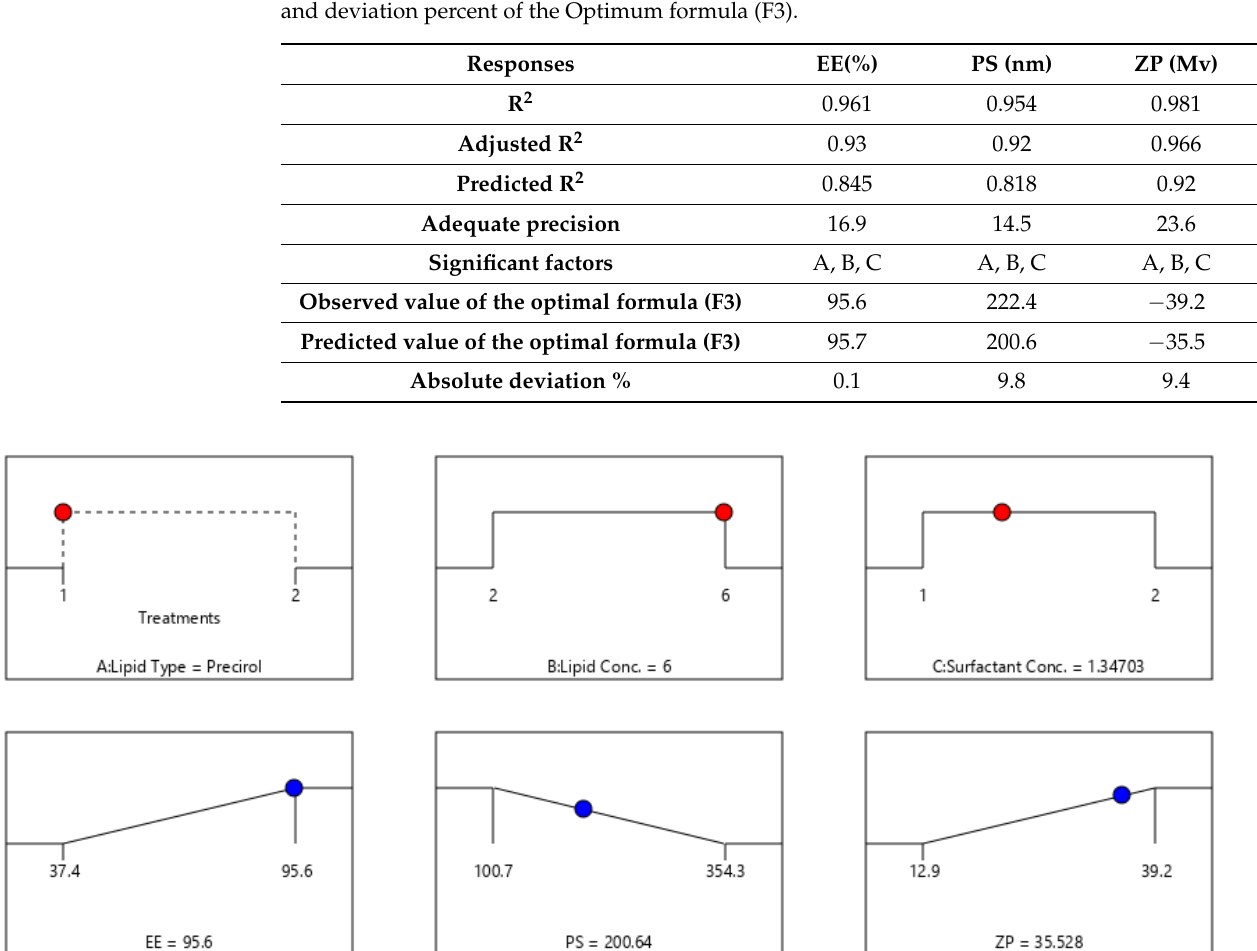
Table 3. 2 3 factorial investigation outcome of 4h -loaded NLC and the predicted, observed responses and deviation percent of the Optimum formula (F3).